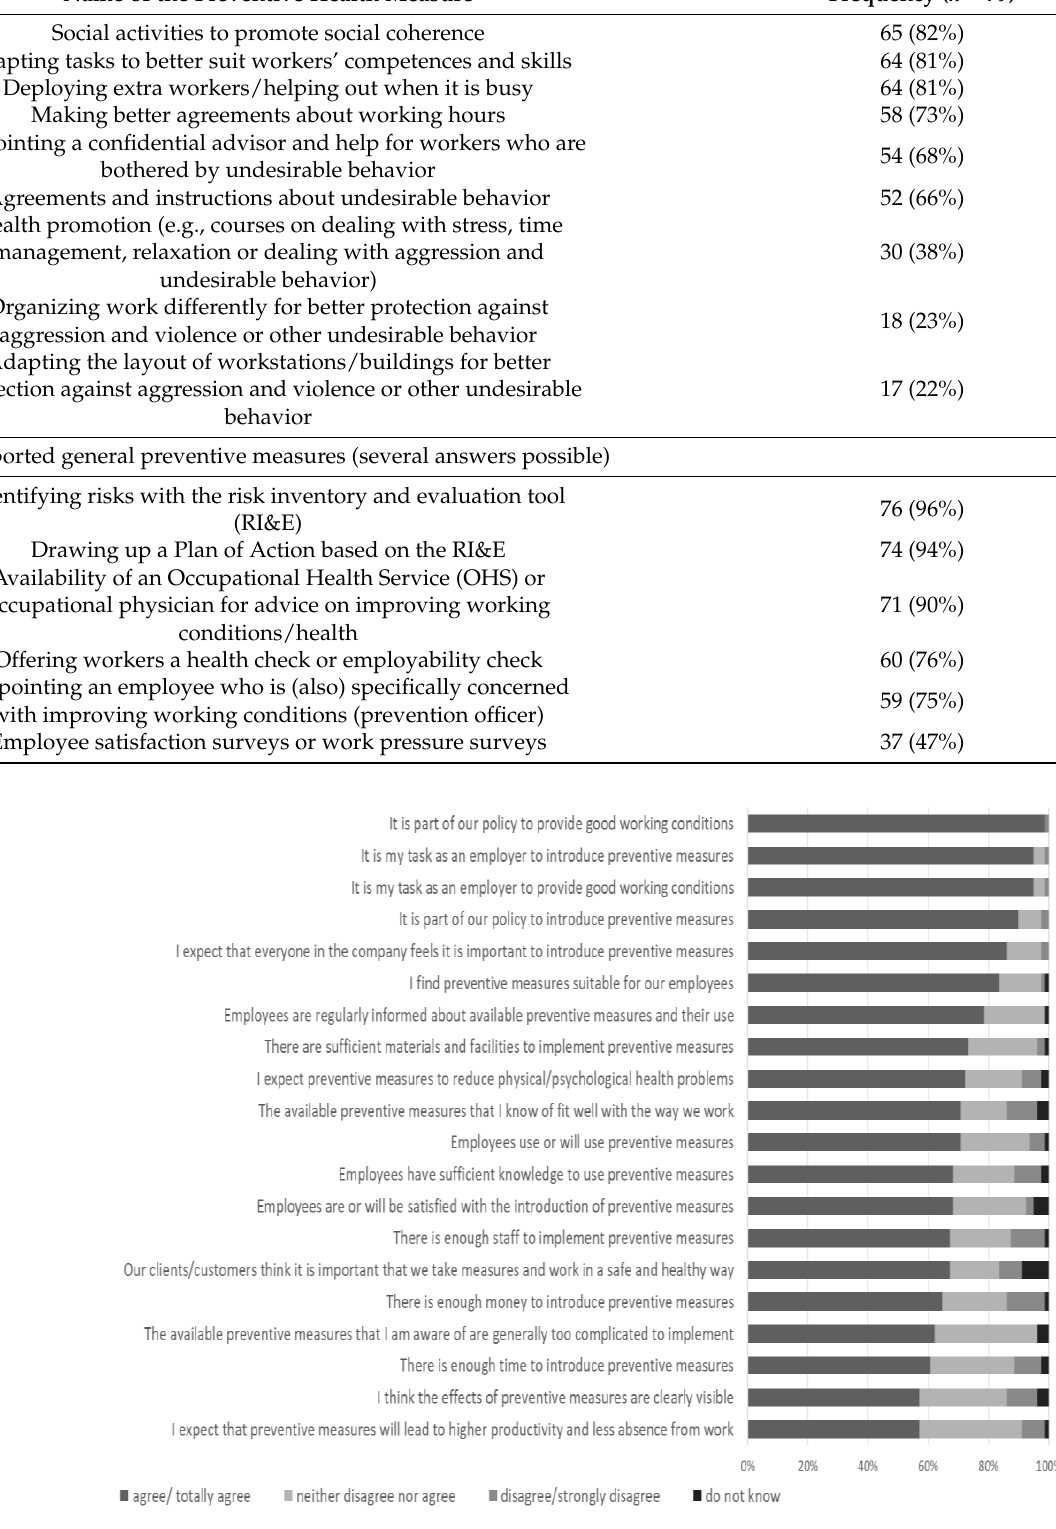
Figure 1. MIDI determinants of implementation ( n = 79).